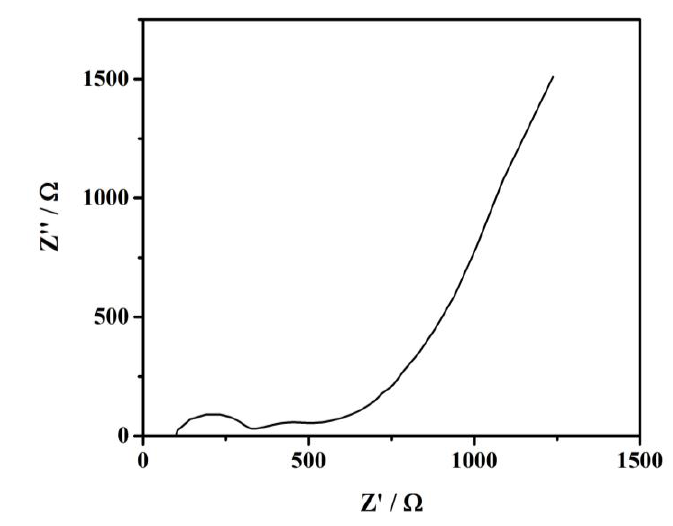
Figure 7: Nyquist plot obtained for the redox capacitor.